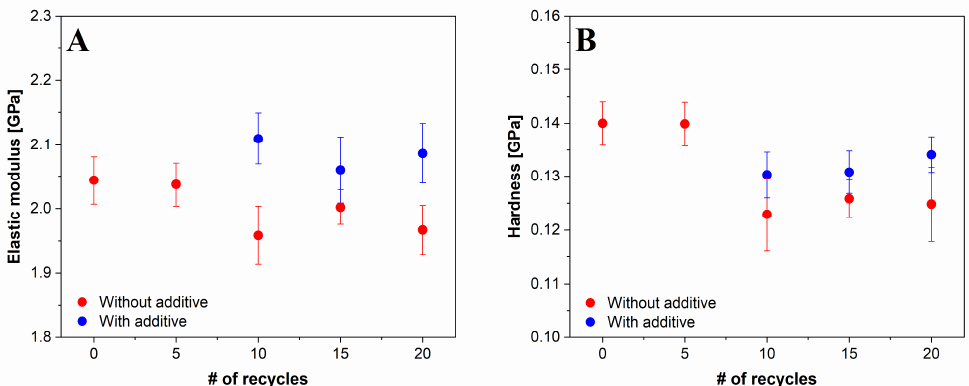
Figure 9. Average values of ( A ) elastic modulus and ( B ) hardness of virgin PP, recycled PP without and with additive. The average analysis depth was from 800 to 1800 nm.